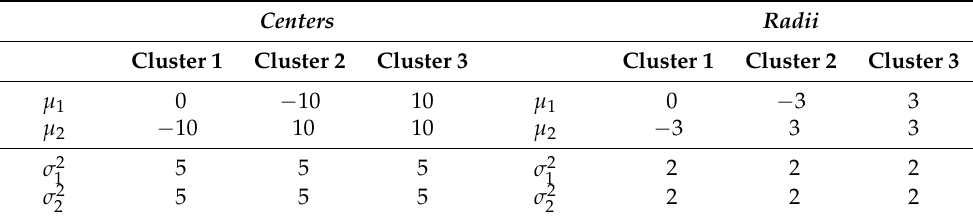
Table 1. Clusters mean and variance of an artificial interval-valued